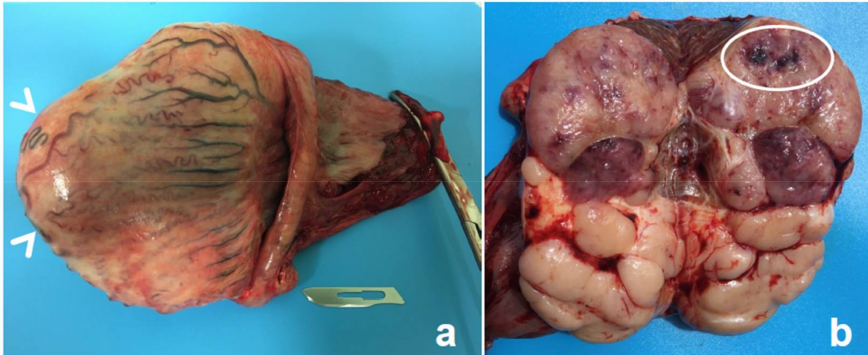
Figure 7. Horse testis. At the external inspection ( a ), the shape of the testicle is partially altered, due to the presence of a large bulge (white arrowheads). On the cut section ( b ), the features of the testicular parenchyma are completely modified. About 50% of the surface appears to be invaded by a cluster of whitish, lardaceous nodules (lower part of the picture), while the remaining part was reddish-to-greyish, with hemorrhagic foci also being evident (bounded with a white line).